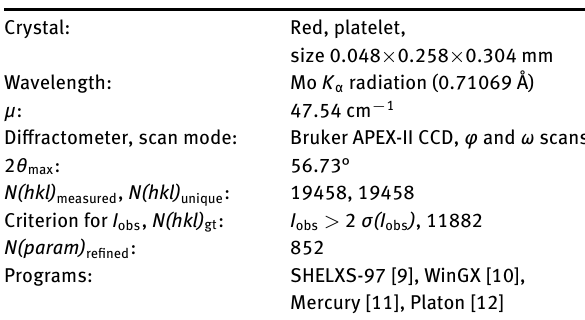
Table 1: Data collection and